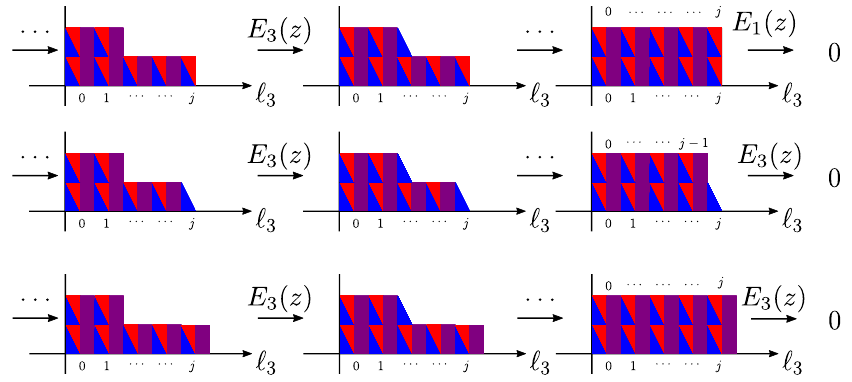
Figure 49. Action of generators on second tensor component of V ( ‘ 3 ) ( u ) ⊗ V ( ‘ 3 ) ( q − 1 when the first tensor component is [ u ] second tensor component will be zero due to K Bottom: when the first tensor component is [ u ] the second tensor component will be zero due to K